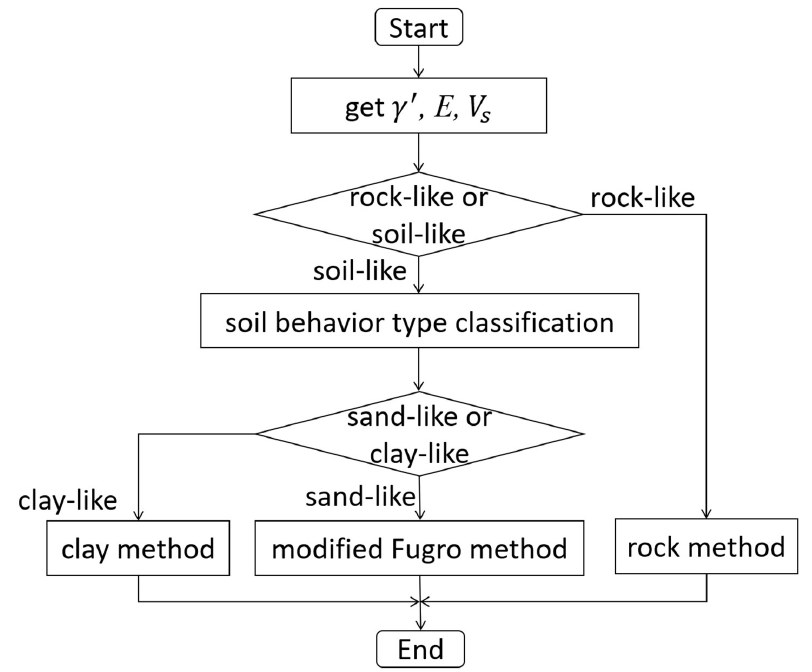
Figure 10. Flow chart of pile drivability.